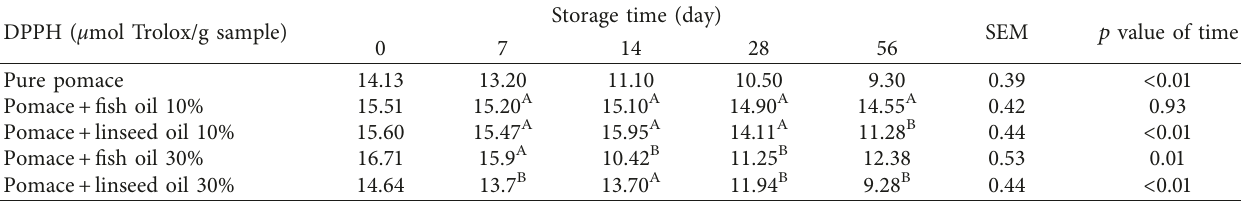
Table 2: The antioxidant activity (DPPH) apple pomace together with the tested oils ( µ mol Trolox/g). DPPH ( µ mol Trolox/g sample)